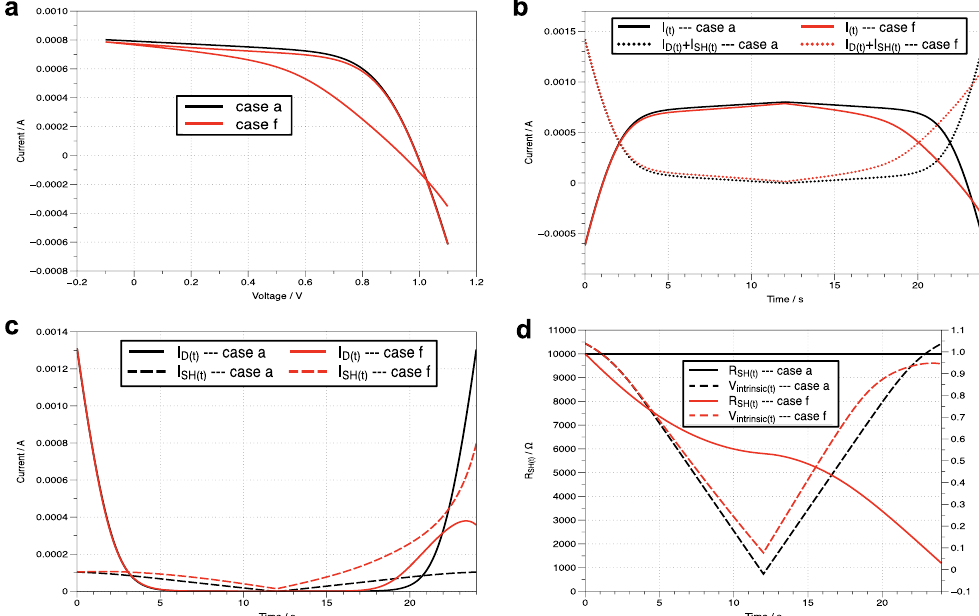
Figure 3. Comparison of the corresponding parameters in cases a and f. ( a) The I–V characteristics of PSCs. (b ) The change regularities of I ( t ) and the sum of I D ( t ) and I SH ( t ) over test time ( t ). ( c ) The change regularities of I D ( t ) and I SH ( t ) over test time ( t ). ( d ) The change regularities of R SH ( t ) and V intrinsic ( t ) over test time ( t